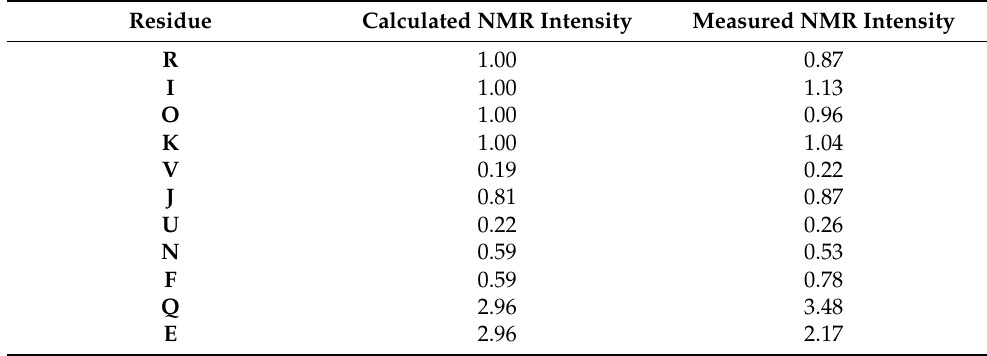
Table 6. Comparison of measured vs. calculated NMR intensity of anomeric protons based upon the number of residues in proposed structures in Figure